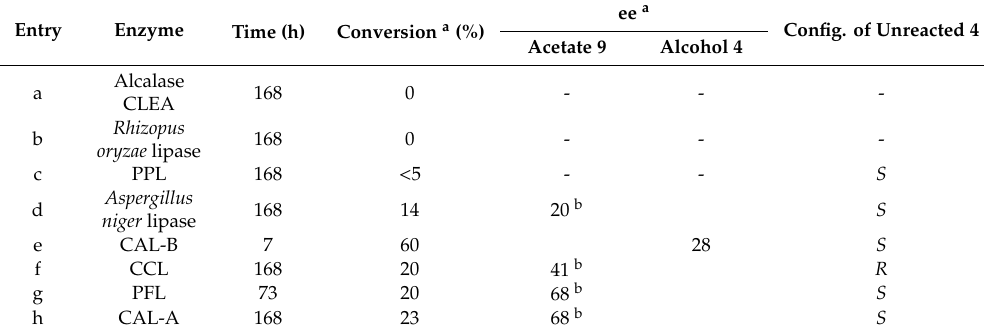
Table 2. Enzyme-catalyzed irreversible transesterification of alcohol rac - 4 in THF.